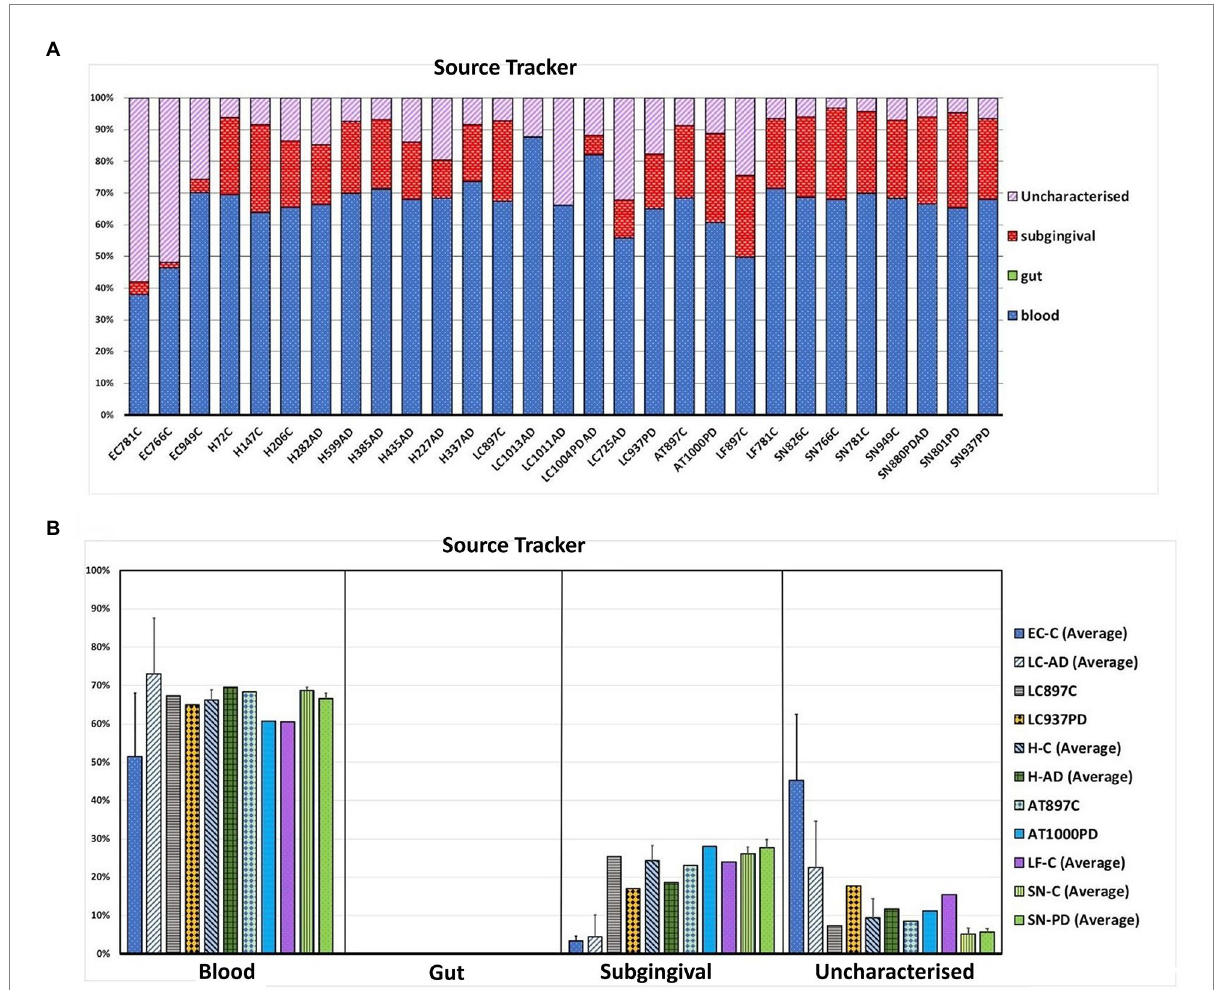
FIGURE 9 Source tracking using blood, gut and subgingival tissue as training sets for the microbial profiles of these areas. (A) Proportions of bacteria matching each source in individual brain samples. (B) Averaged values (where applicable) per group per predicted source. Bacterial sequences in the brain samples are shown to be similar at 65.2% on average to the blood training set. No gut content of brain samples was seen, however, a number of bacteria in brain samples did not match the training sets and were thus denoted as